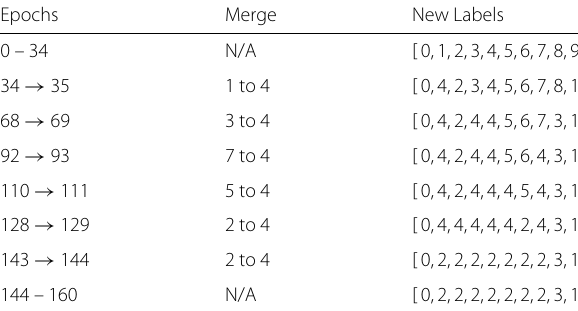
In Fig. 7, the number of active port pairs extracted from ‘test data 1’ is plotted against time (in seconds) and the bars in the upper and lower halves represent the classes predicted by our trained neural net and the true labels of the test segments, respectively; segments which result in prediction errors are considered anomalies.